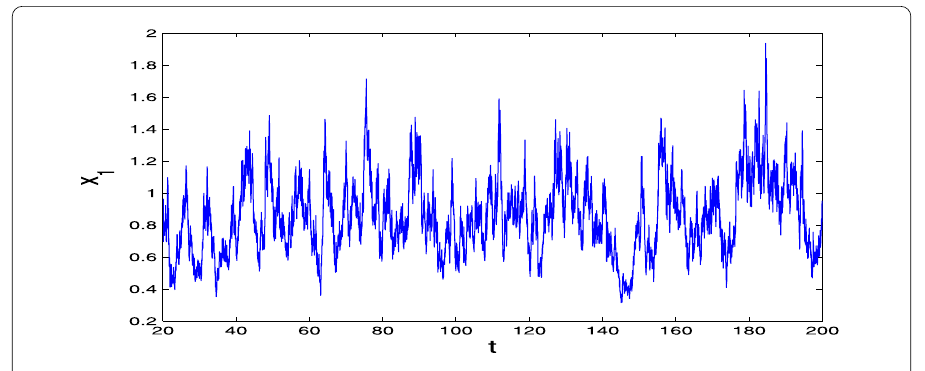
Figure 1 Stochastic trajectory of x 1 ( t ) for system (61) with σ 1 (1) = 0.2, σ 1 (2) = 1.0, σ 2 (1) = 0.2, σ 2 (2) = 0.5.